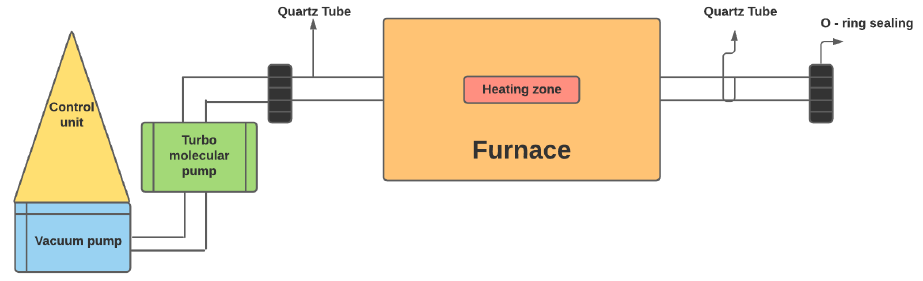
Figure 1. Turbo-molecular pump assisted vacuum furnace